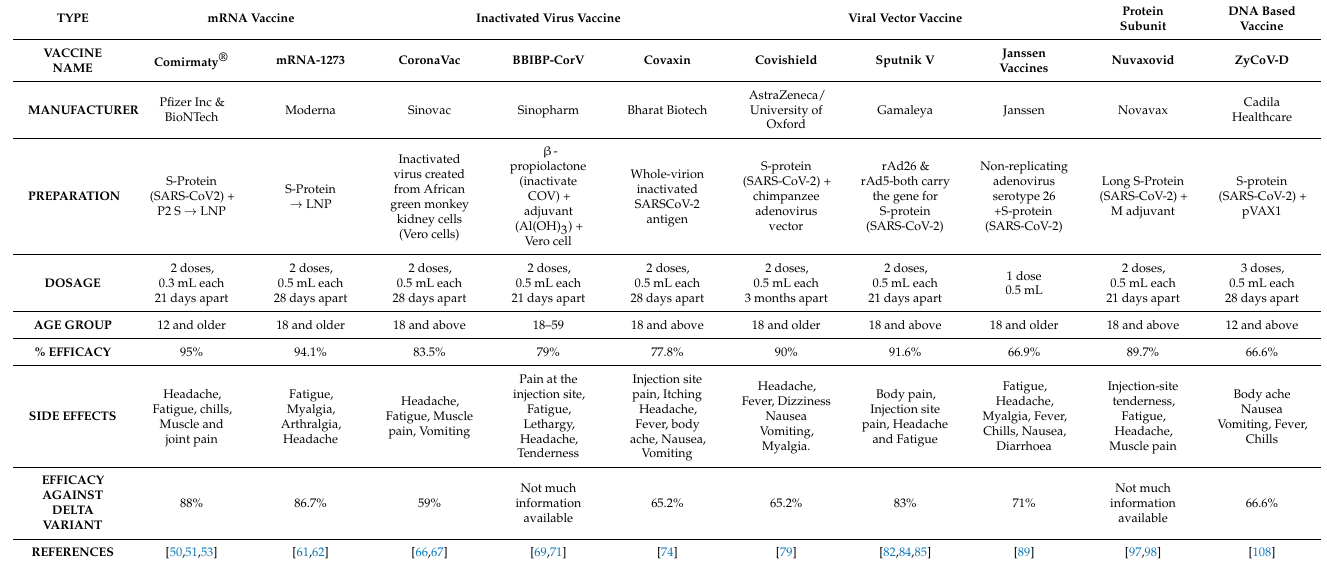
Table 1. Comparison of different COVID-19